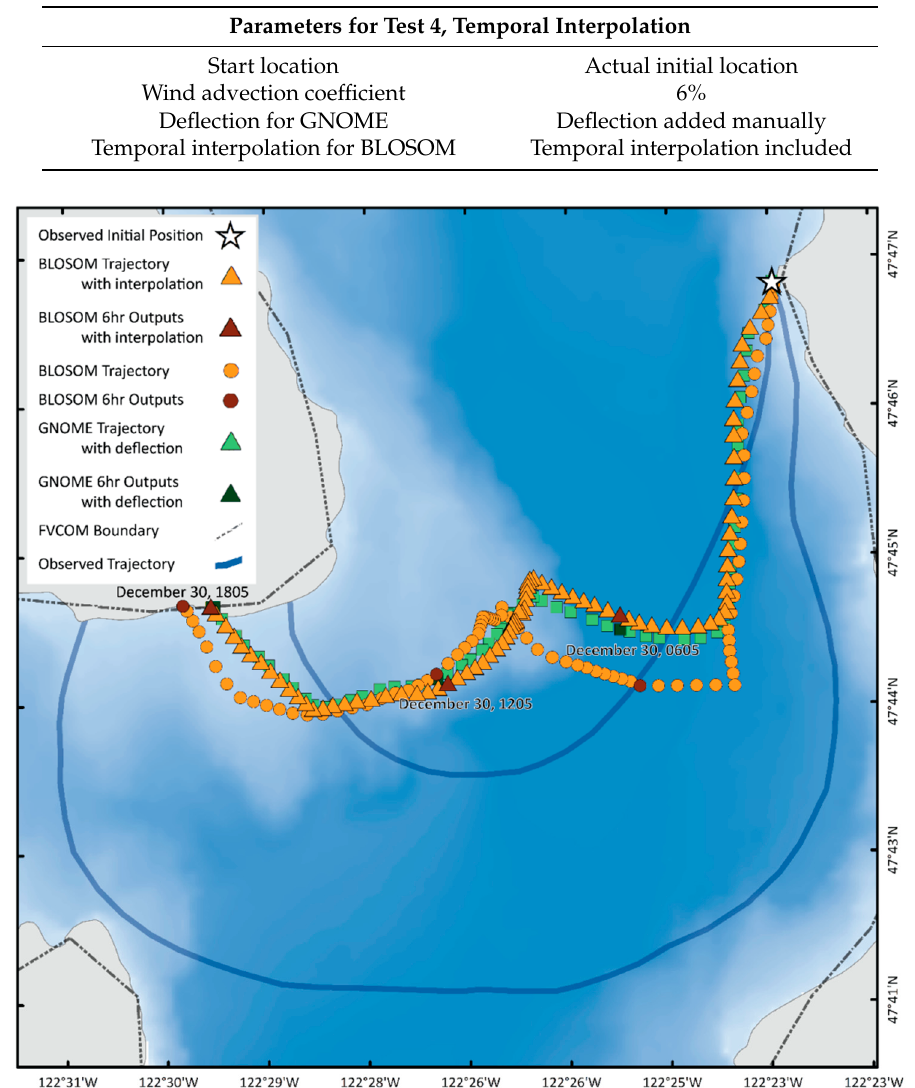
Figure 14. The trajectories for GNOME and BLOSOM, both with deflection included, as seen in Figure 13, are compared to the same BLOSOM trajectory, but now including temporal interpolation; test 4. The trajectory from GNOME with added deflection, and the trajectory from BLOSOM with added interpolation, now resemble each other closely.